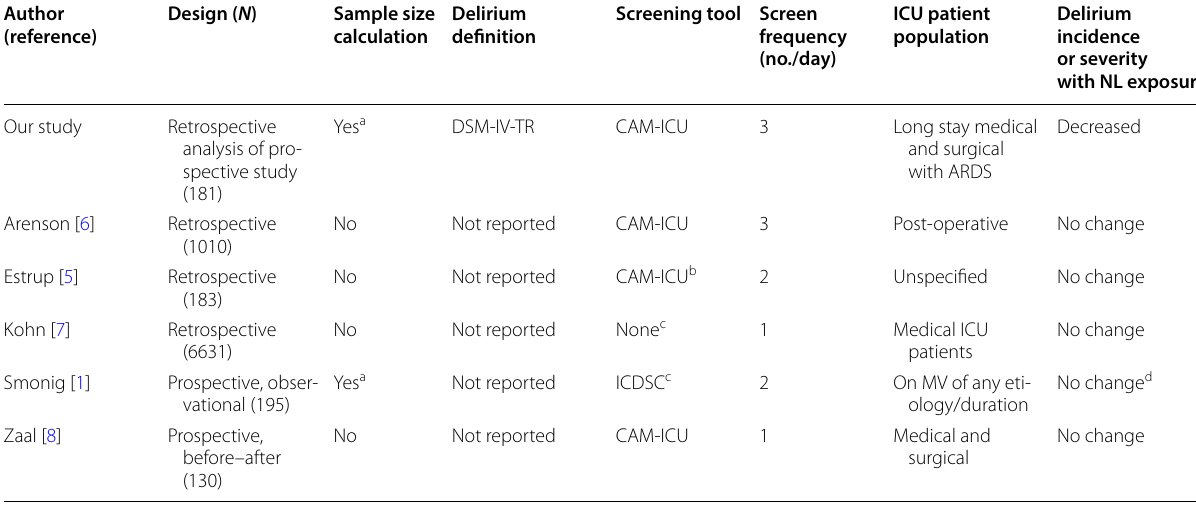
Table 1 Design heterogeneity in studies on the effects of natural light exposure on patients in the intensive care